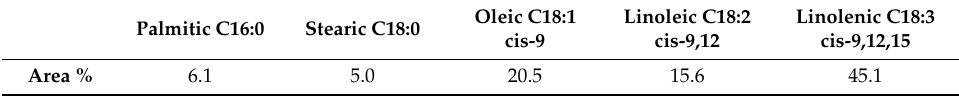
Table 2. Composition of fatty acids in refined linseed oil, as extracted from Figure S2.